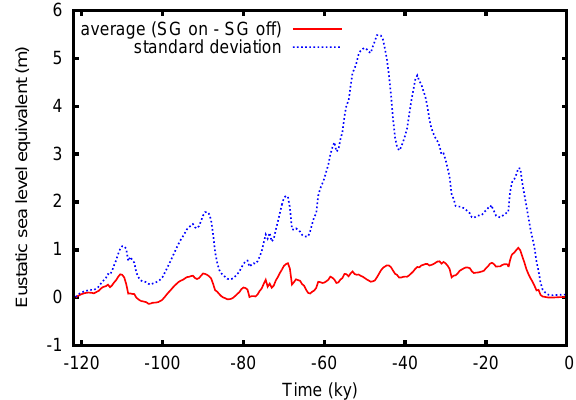
Figure 10. Ensemble mean (solid red line) and standard deviation (dotted blue line) eustatic sea level equivalent of the total ice volume differences when the SG model is turned on and off, for an ensemble run over the last glacial cycle.